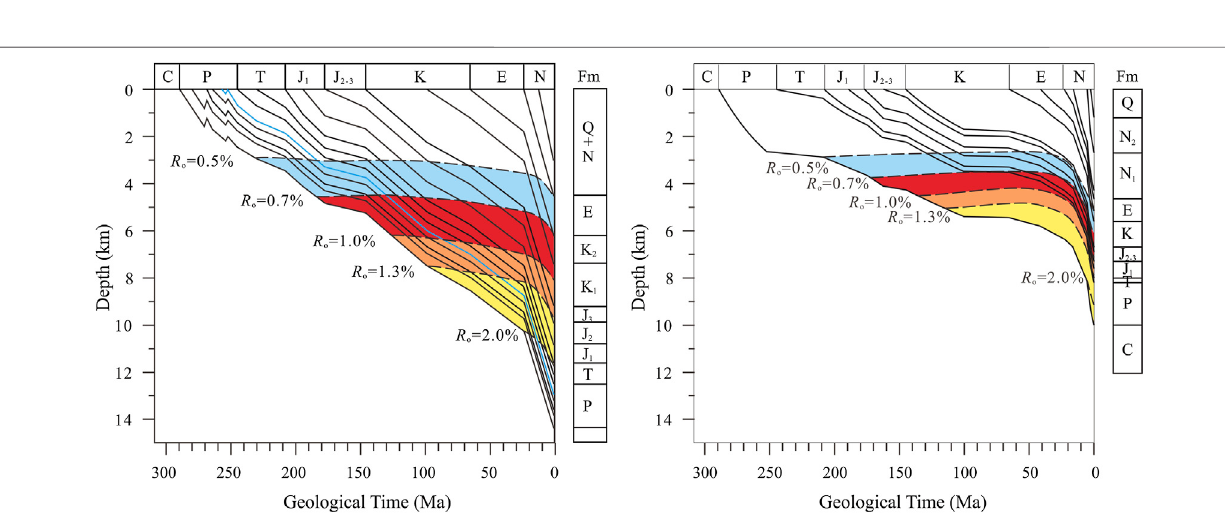
Frontiers in Earth Science |